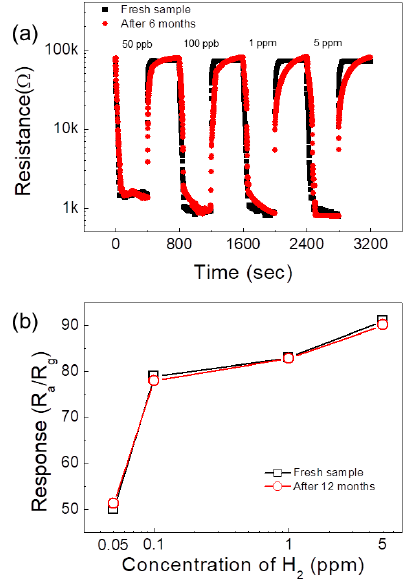
Figure 9. ( a ) Long-term stability curves of fresh and 6 months aged 0.1 SnO 2 -loaded ZnO NF gas sensor. ( b ) Response versus H 2 gas concentration of fresh and 6 months aged 0.1 SnO 2 -loaded ZnO NF gas